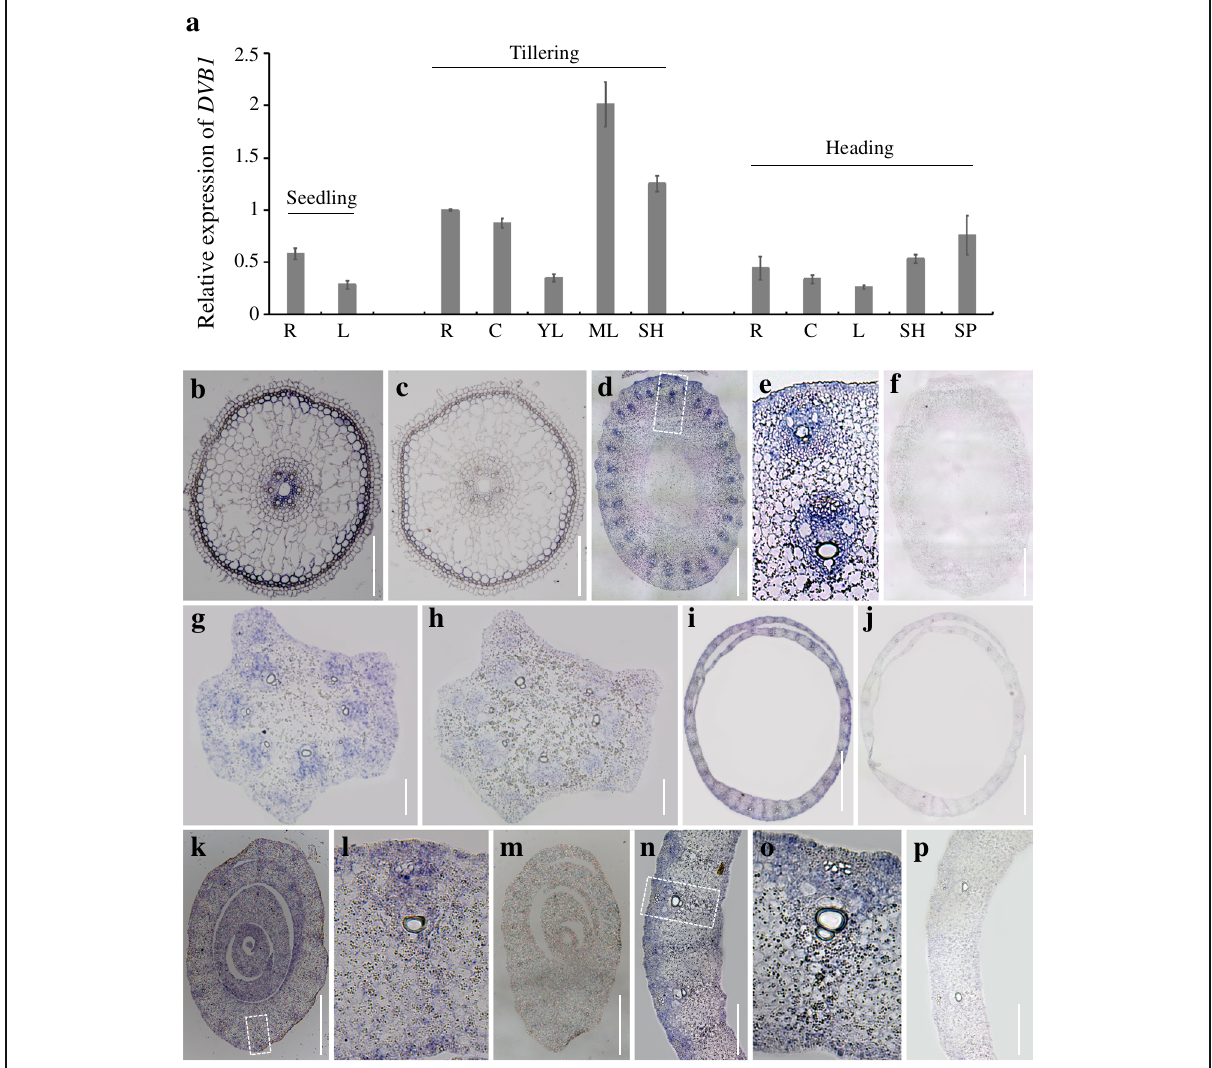
Fig. 4 Expression pattern and RNA in situ hybridization of DVB1. a Abundance of DVB1 transcripts in different tissues at the seedling, tillering, and heading stages. R, root; L, leaf; C, culm; YL, young leaf; ML, mature leaf; SH, sheath; SP, spikelet. Error bars indicate the standard deviation (SD)